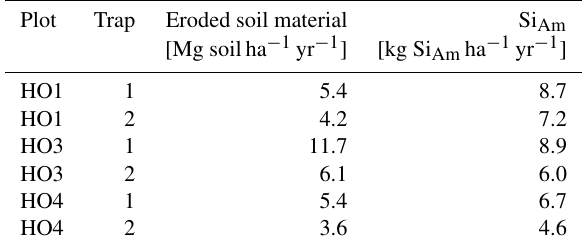
Table 2. Annual losses of soil and Si Am through erosion. Plot Trap Eroded soil